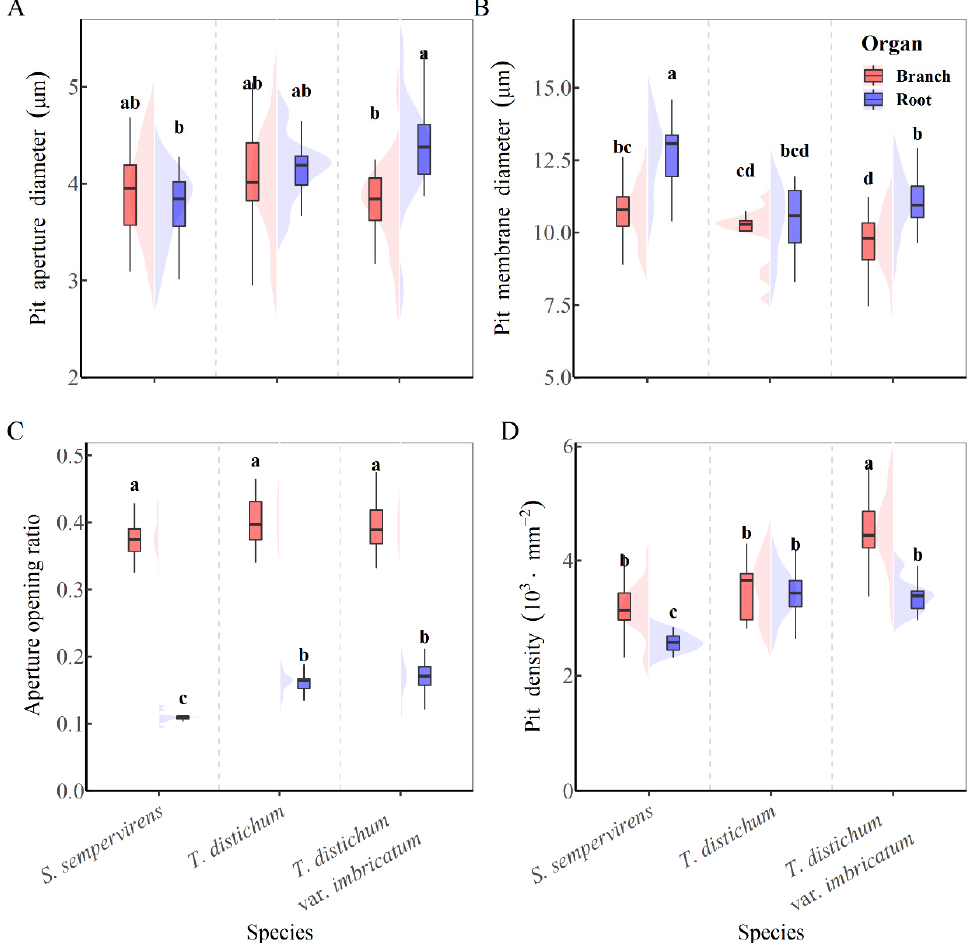
Figure 4. Pit aperture diameters ( D pa , A ), pit membrane diameters ( D pm , B ), aperture opening ratio ( F a , C ), and pit density ( N p , D ) of the branches and roots the in three taxa. Different letters indicate a significant difference between means at p < 0.05 (multiple comparisons of treatments by means of a Tukey test).